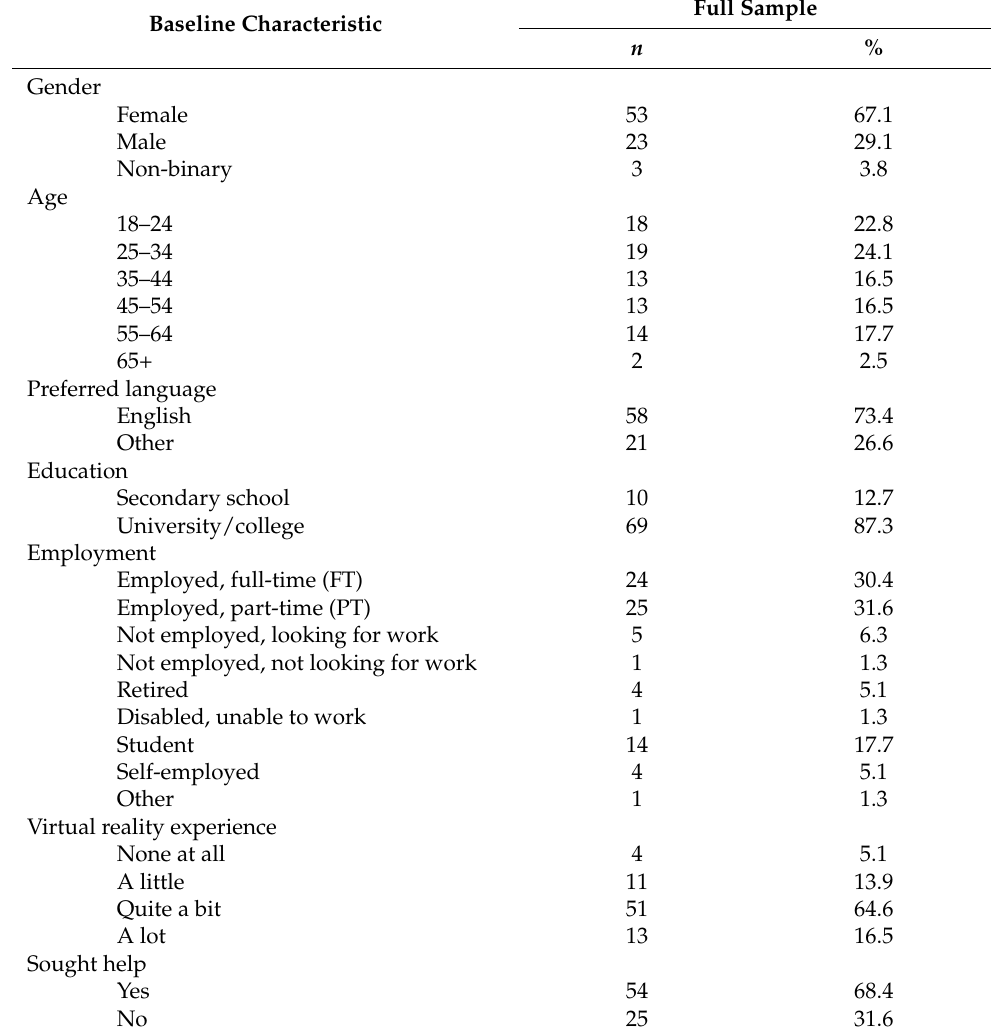
Table 1. Demographic variables of entire sample (N =